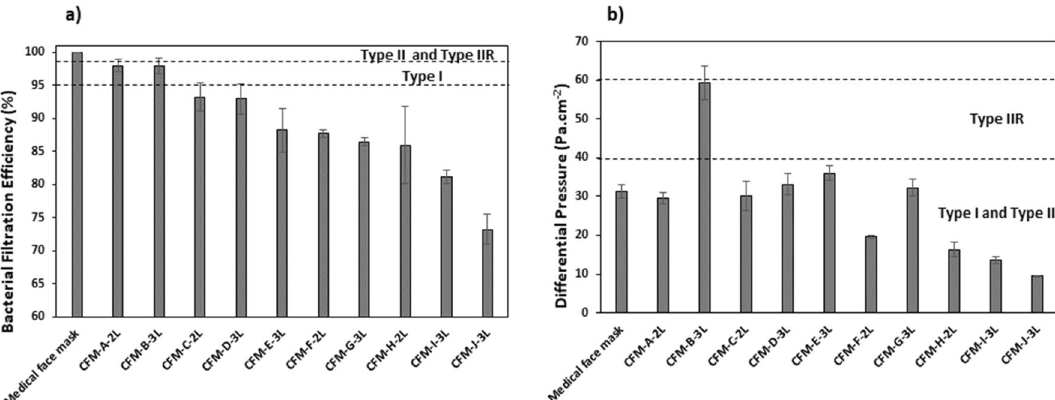
Figure 2. ( a ) Bacterial Filtration Efficiency (%) and ( b ) Differential pressure (Pa cm −2 ) for the medical face masks and community face masks, (average values (N = 5) ± standard-deviation). CFM corresponds to Community Face Masks, 2L corresponds to 2 layers and 3L to 3